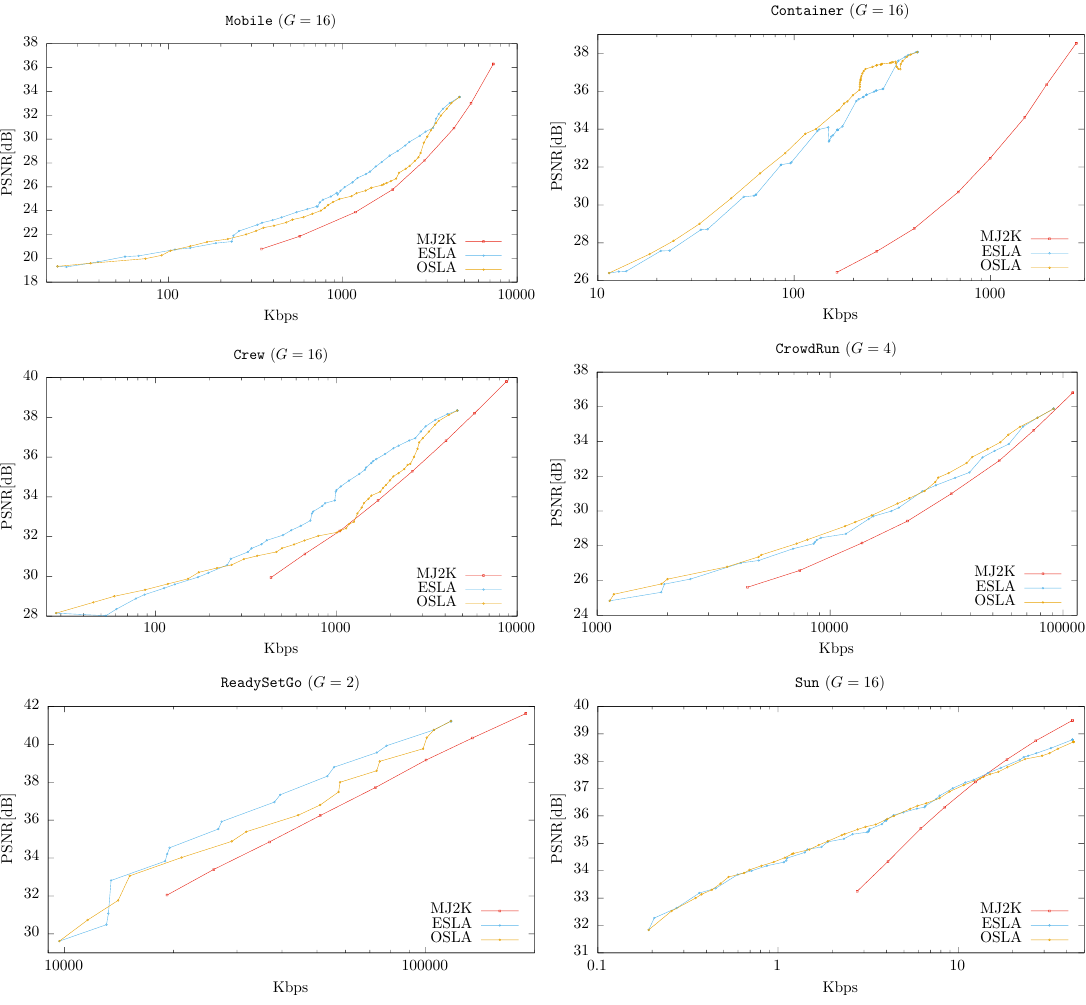
Figure 6. MCJ2K (using OSLA or ESLA) vs. MJ2K for different